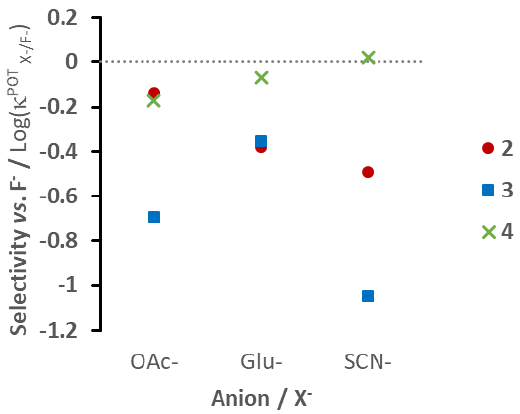
Figure 3. Relative selectivity, Log( κ POT X- / F- ), obtained with each polymer ( 2 – 4 ), estimated for F − vs. each anion X − , where the gray horizontal dashed line is the reference value for the fluoride target guest.